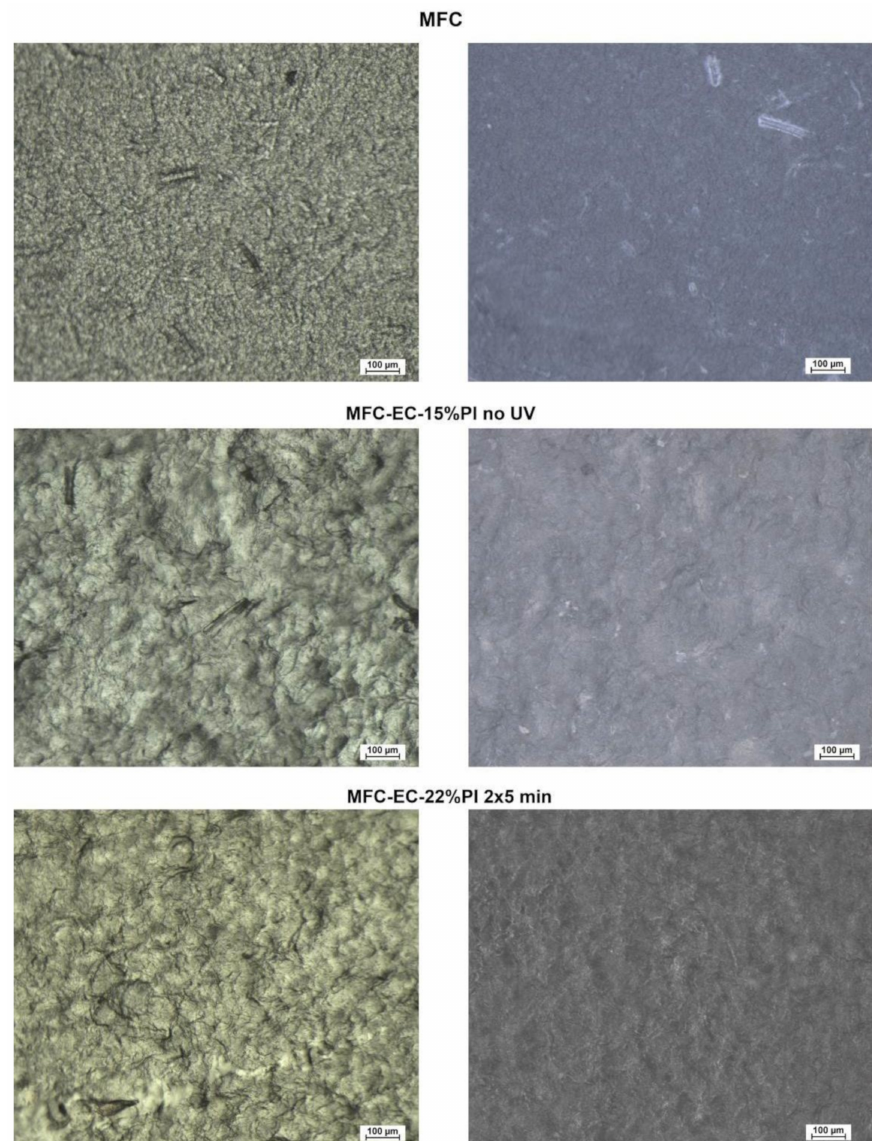
Figure 3. Bright field transmission (left) and reflection (right) images of: dry MFC mat, MFC-EC-15%PI before UV exposure, and MFC-EC-22%PI with 5 min of UV exposure per